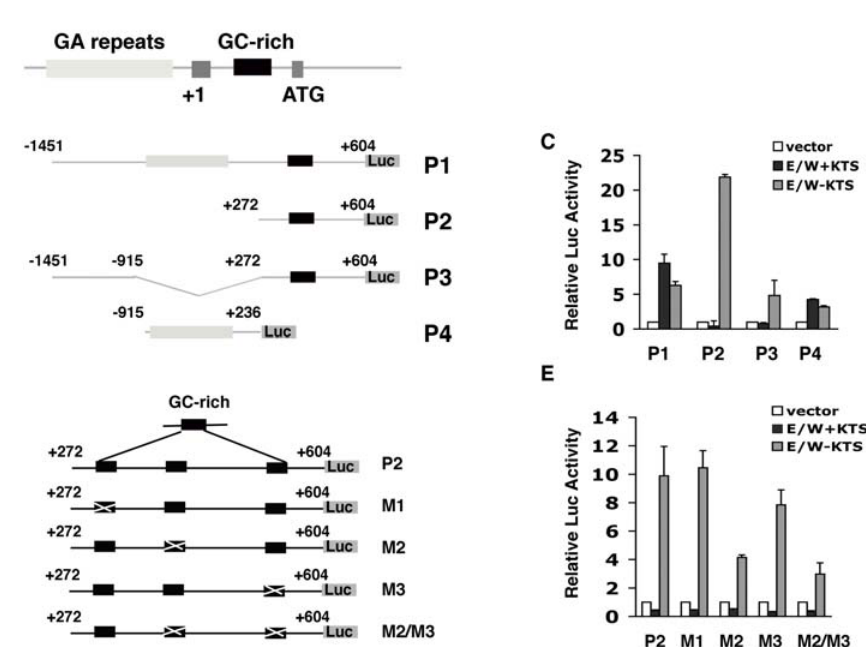
Figure 2. Identification of EWS-WT1( + KTS) and ( 2 KTS) responsive elements in the human ENT4 promoter. A. Schematic representation of ENT4 gene. The dark grey box indicated by + 1 represents the first non-coding exon and the transcription start site ( + 1). The second dark grey box marked by ATG represents exon 2 containing the starting ATG. The light grey box represents the GA-repeat sequence. The black box represents the GC-rich sequence. B. Schematics showing the luciferase reporter constructs (P1–P4) containing different fragments of the ENT4 promoter. P3 promoter construct contains the deletion of GA-repeat sequences ( 2 915 to + 272). The numbers are relative to the transcription start ( + 1). C. Direct transcriptional activation of ENT4 promoters by EWS/WT1. U2OS cells were co-transfected with either pcDNA3-EWS/WT1 ( 2 or + KTS; 0.5 m g) or with pcDNA3 along with the promoter-reporter constructs (P1, P2, P3 or P4; 0.5 m g) and Renilla luciferase (0.1 m g) using FuGENE 6. Luciferase activity was measured at 48 hrs post-transfection and expressed as relative luciferase activity compared to the empty vector. Data represent the mean 6 S.D. from three independent experiments. D. Schematics showing the three putative EWS/WT1( 2 KTS) binding sites (black boxes) within the GC-rich region of the P2 promoter and the mutated derivatives, M1, M2, M3 and M2/M3 constructs (see Materials and Methods for detail). E. Identification of the EWS/ WT1( 2 KTS) responsive element M2. Luciferase-reporter assay was performed as in (C) except with the promoter-reporter constructs shown in (D). Data represent the mean 6 S.D. from three independent